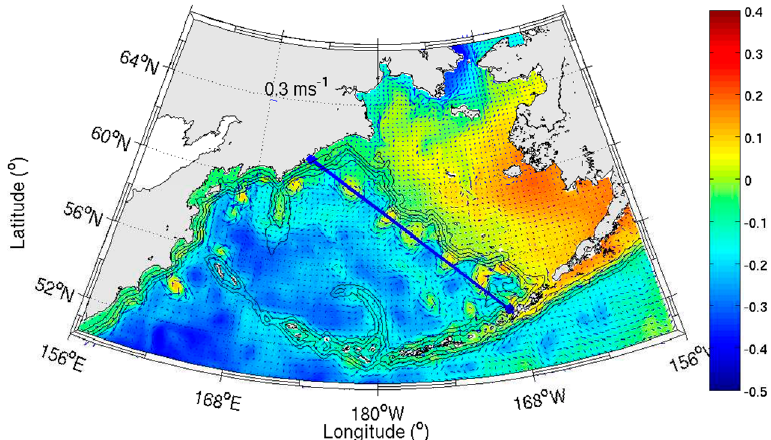
Figure 12. Snapshot on April 20th, 1994 of the surface eddy street along the Bering Slope from the 5 day averaged model data. The color is the relative vorticity normalized by the local Coriolis coefficient. The vector denotes the surface current. Contours denote the water depths of 200 m, 500 m, 1000 m, and 2000 m, respectively, as shown in Figure 1.